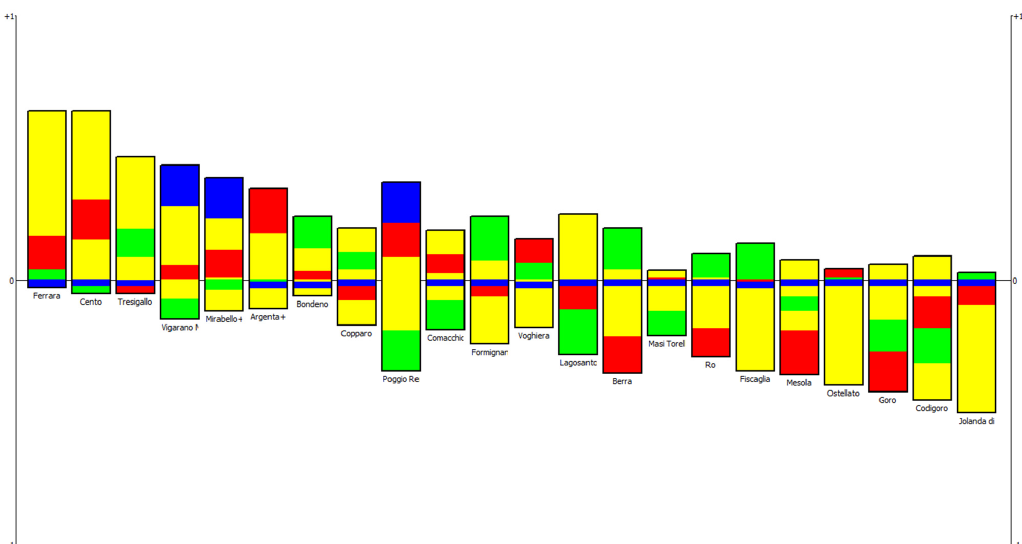
Figure 9. PROMETHEE rainbow plot for the usual preference function. On the vertical axis, the preference function Θ is reported. The yellow bar indicates the criteria relating to exposure, red is used for seismic hazard, green for vulnerability, and blue for hydraulic hazard.